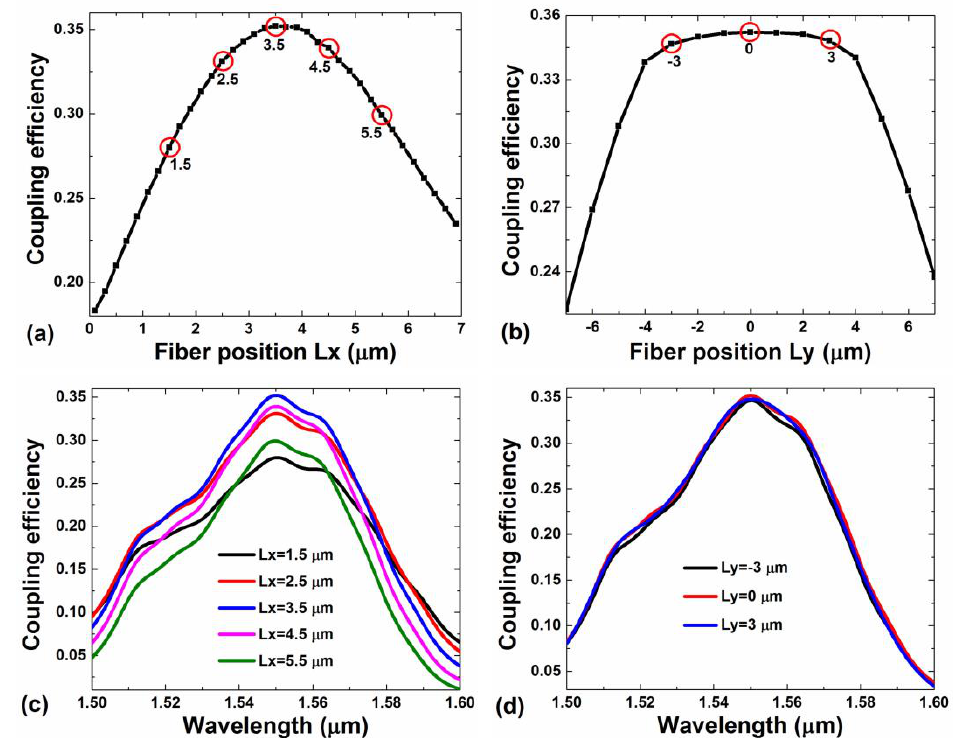
Figure 3. Coupling efficiency as a function of Lx ( a ) and Ly ( b ) and: coupling efficiency as a function of wavelength for different Lx ( c ) and Ly ( d ).